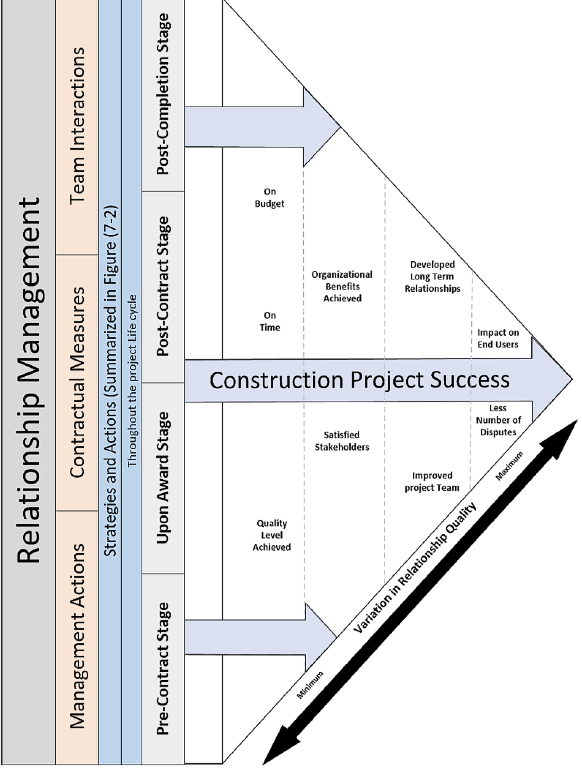
Figure 5. Framework for RM in UAE construction industry